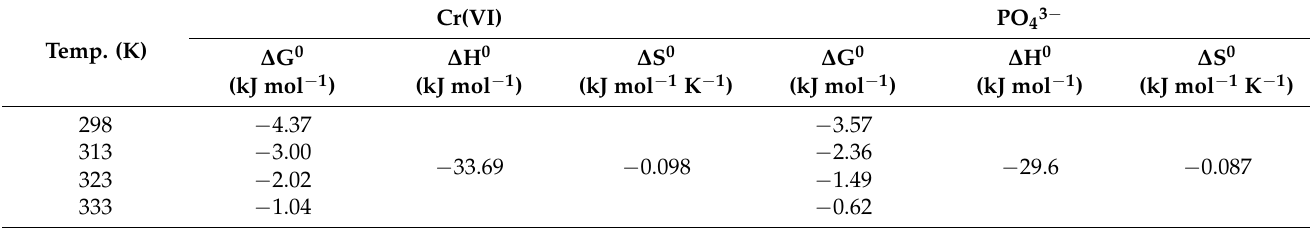
Figure 9. van’t Hoff plots. Table 3. Thermodynamic parameters.